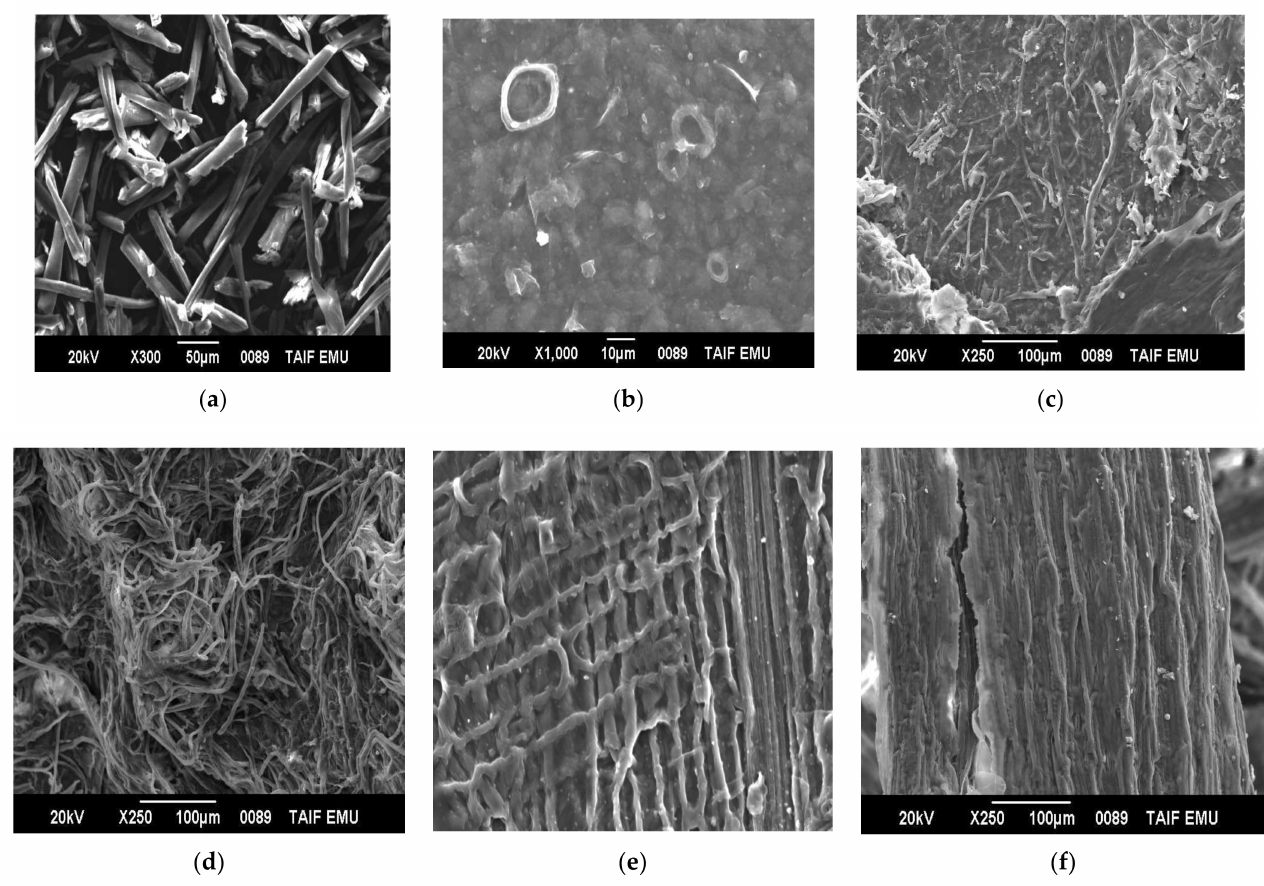
Figure 8. SEM of RSNFC; ( a , b ) acid hydrolysis before and after treatment by ultrasonic waves, ( c , d ) al- kali hydrolysis before and after treatment by ultrasonic waves, and ( e , f ) for sodium hypochlorite before and after treatment by ultrasonic